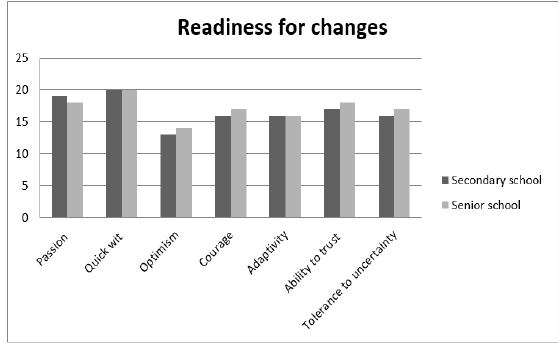
Figure 2. The results of the scale “Self esteem of innovative traits” in groups of sec -